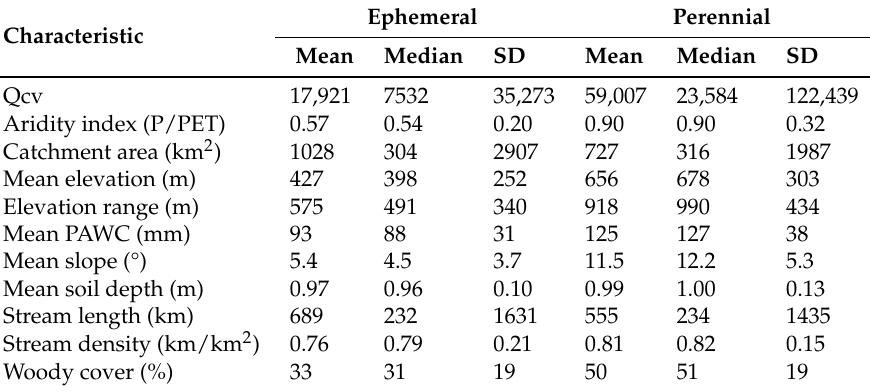
Table 2. Numerical summary of the catchment characteristics by catchment type: ephemeral ( n = 57) and perennial ( n =